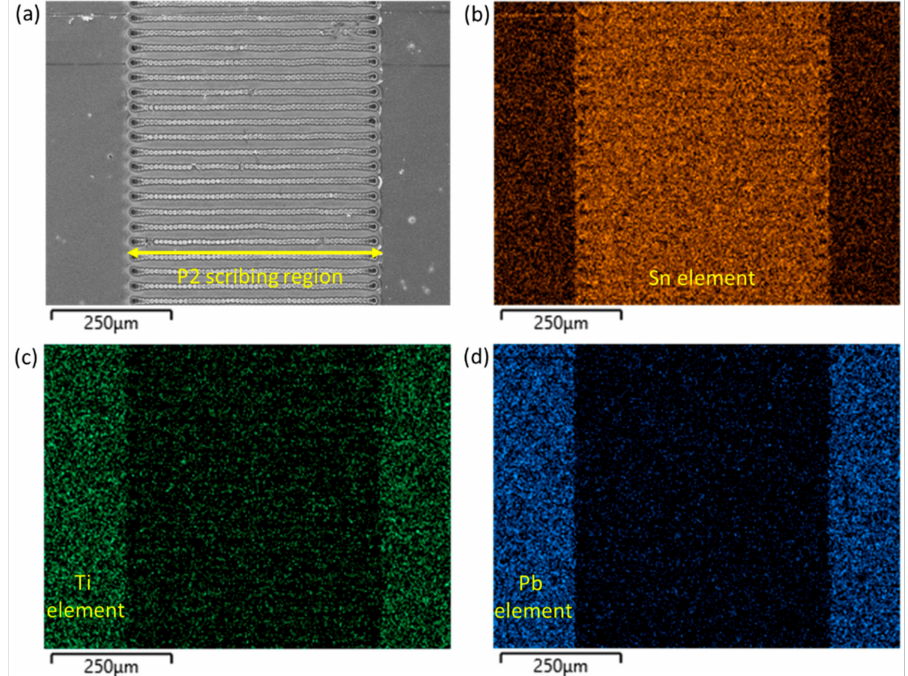
Figure 2. ( a ) SEM image and corresponding elemental mapping ( b ) Sn signal ( c ) Ti signal ( d ) Pb signal of P2